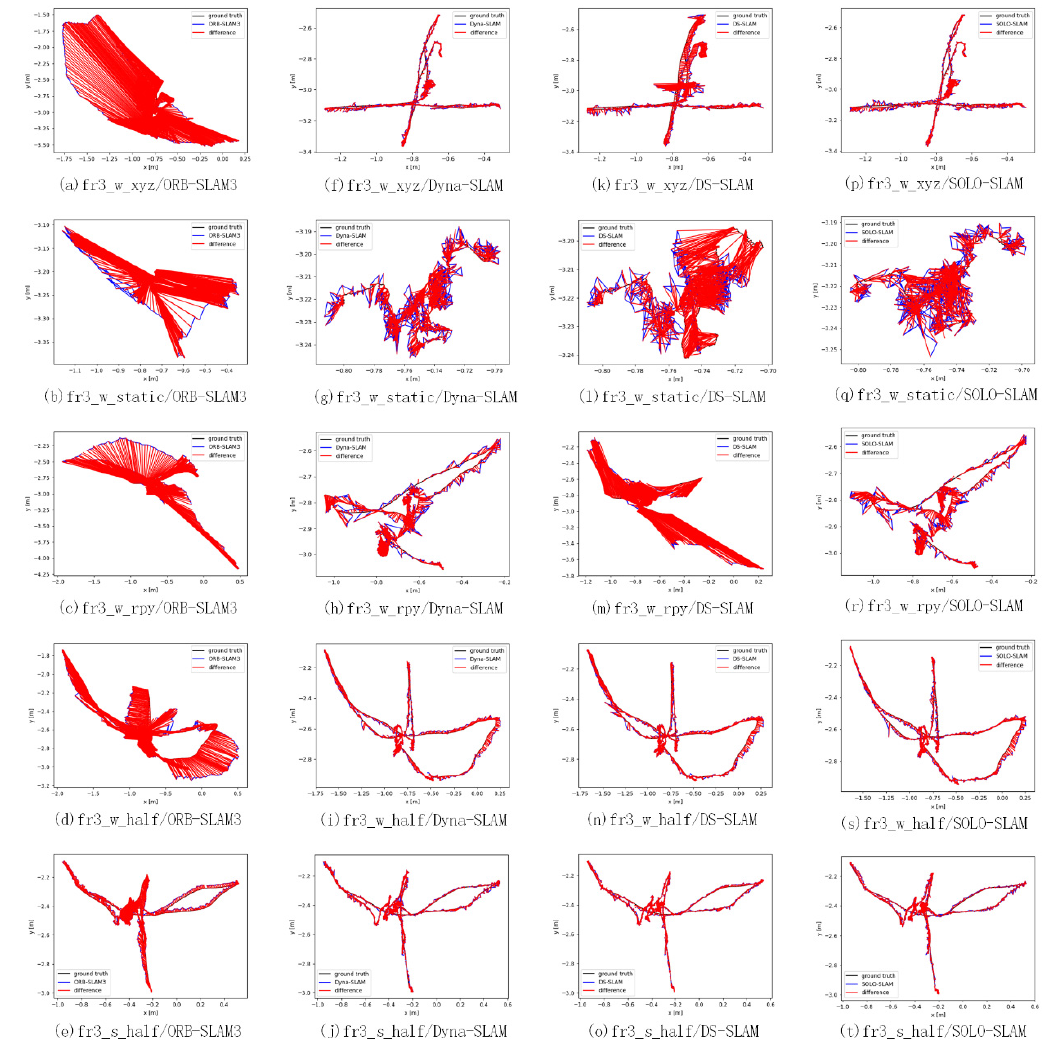
Figure 11. Track diagrams of different dynamic scenes. ORB-SLAM3 corresponds to ( a – e ); Dyna- SLAM corresponds to ( f – j ); DS-SLAM corresponds to ( k – o ); SOLO-SLAM corresponds to ( p – t ). The red line corresponds to the difference between the ground truth and the calculated trajectory. Table 3. Experimental results of translational relative trajectory error.